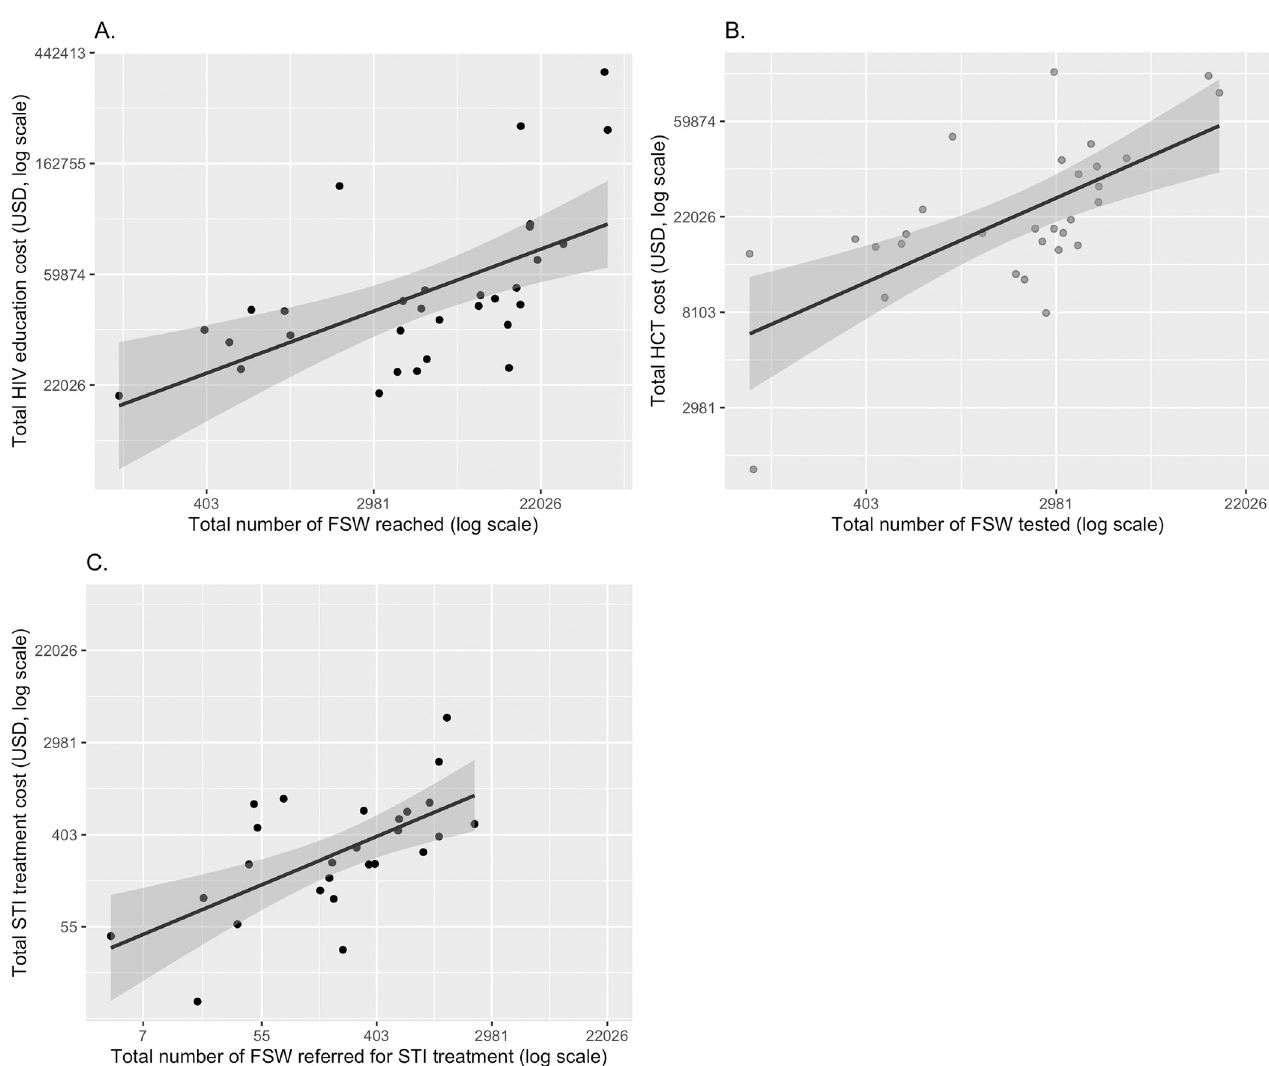
Fig 4. Total cost and scale of services among a sample of Nigerian CBOs providing (A) HIV education services, (B) HIV counselling and testing services, and (C) STI referrals.